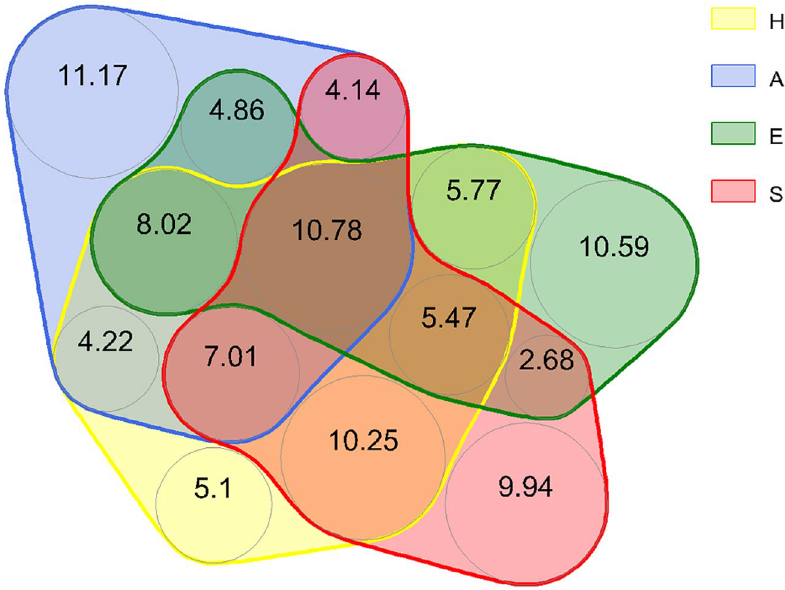
Figure 7. CUVARP diagram (Cumulative Variation Partitioning with Multiple Response and Predictor Matrices). All datasets are synthesized through selected PCoA axes scores of H—native species, A—alien invasives, E—environmental parameters, and S—space. No overlapping colored circles depict unexplained (residual) variation. The percentage of variation (explained and residual) from the total variation in all matrices is shown (the null value of AES overlap is not represented). Graphic alternatives are given in the Supplementary